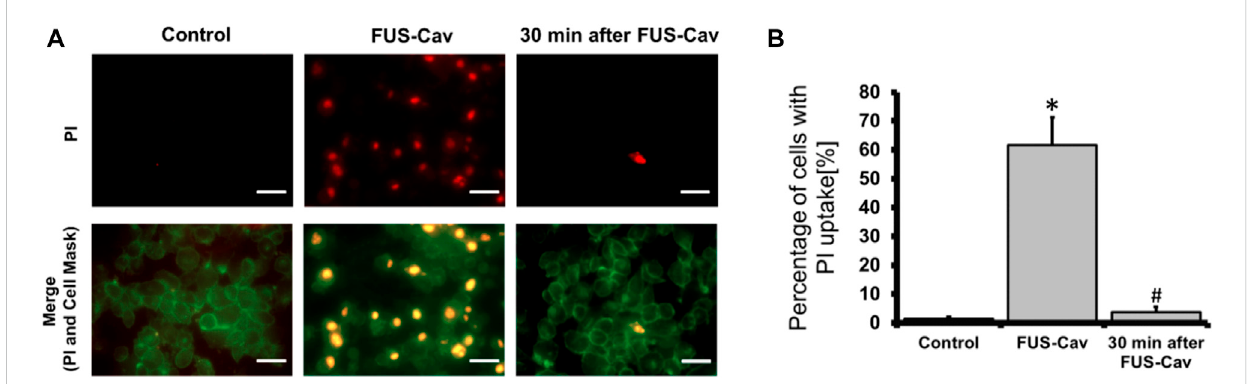
FIGURE 7 FUS-Cav induced sonoporation in LNCap cells. (A) Representative fl uorescence microscopy images for LNCap cells showing an increase in red PI fl uorescence during FUS-Cav; red: PI-stained cell nucleus; green: CellMask ™ stained cell membranes, scale bar = 30 µm. (B) Semi-quantitative analysis of PI-positive percentage representing the quantity of sonoporated LNCap cells. Data were normalized to total cell number as 100% and relative values presented as mean ± SEM, n = 6, *signi fi cantly different from control ( p ≤ 0.05), #signi fi cantly different from FUS-Cav ( p ≤